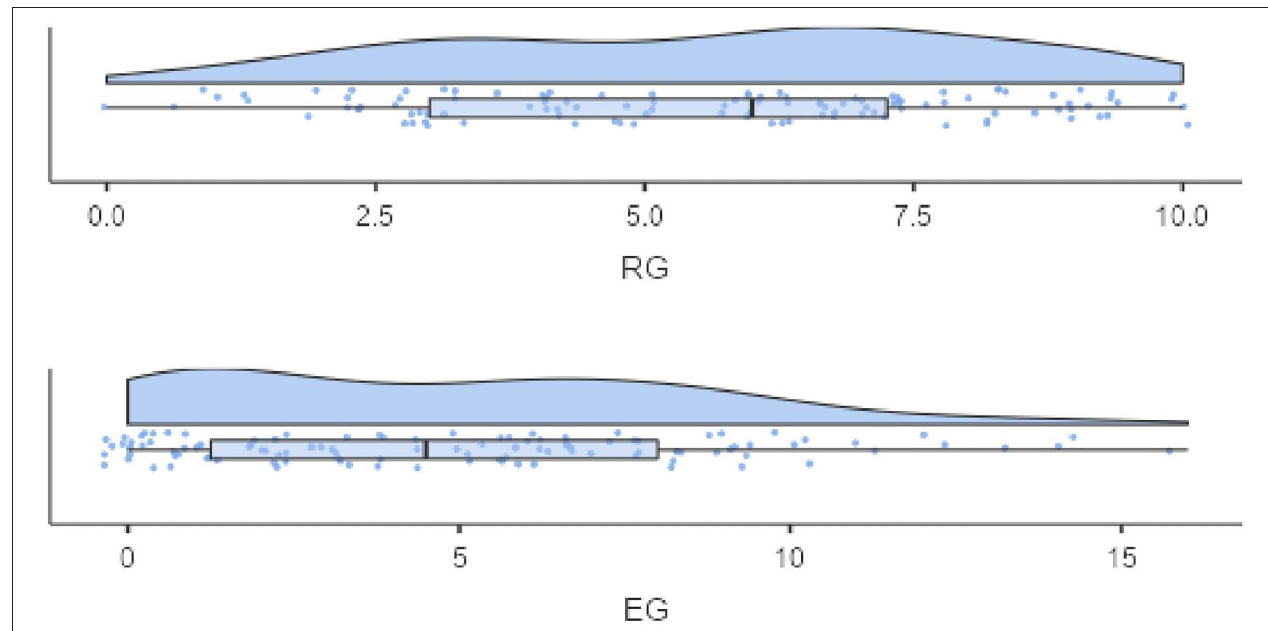
FIGURE 1 | Distribution of the screening subscales—Study 1.